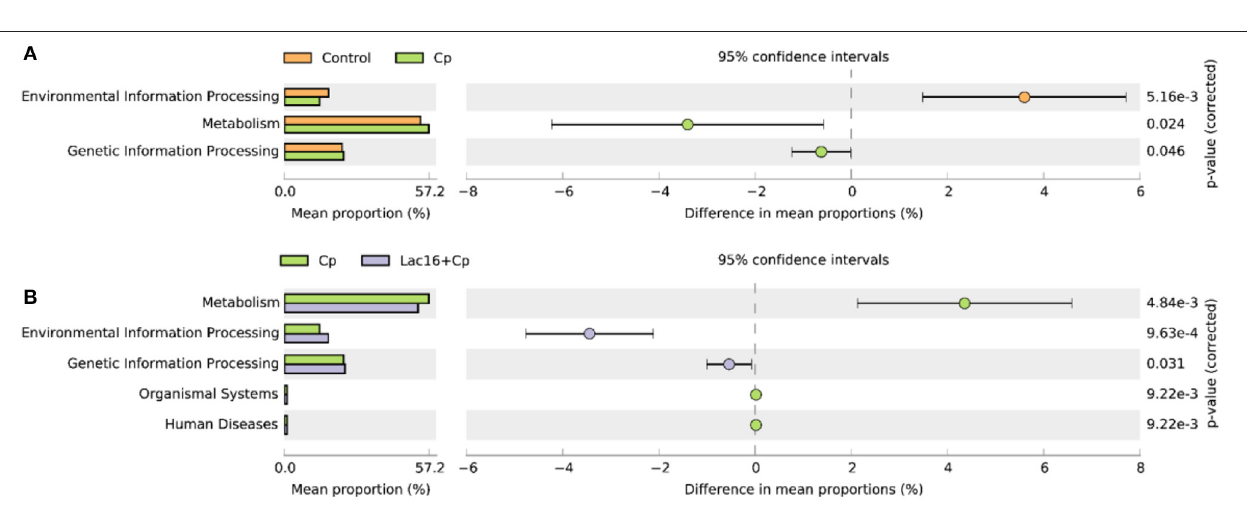
FIGURE 7 | Comparison of predicted metabolic pathway abundances between the groups by statistical analysis of taxonomic and functional profiles ( STAMP ) at Level 1. (A) Control vs. Cp; (B) Cp vs. Lac16 + Cp.